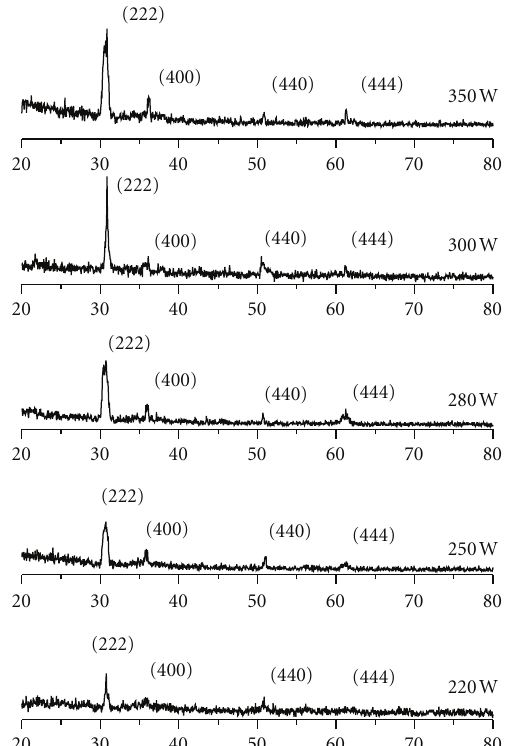
Figure 1: XRD patterns of the ITiO films deposited at di ff erent RF